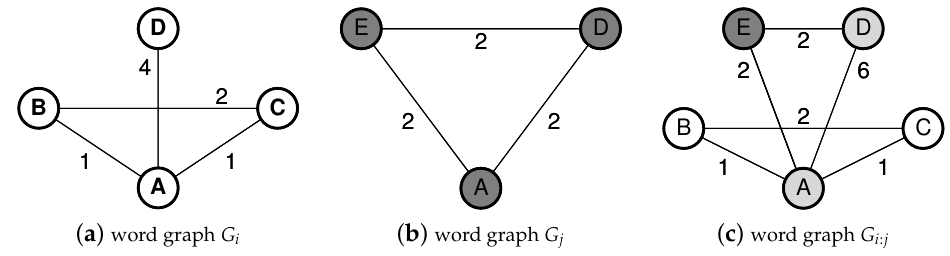
Figure 4. Example of the conjunction process G i : j for word graphs G i and G j